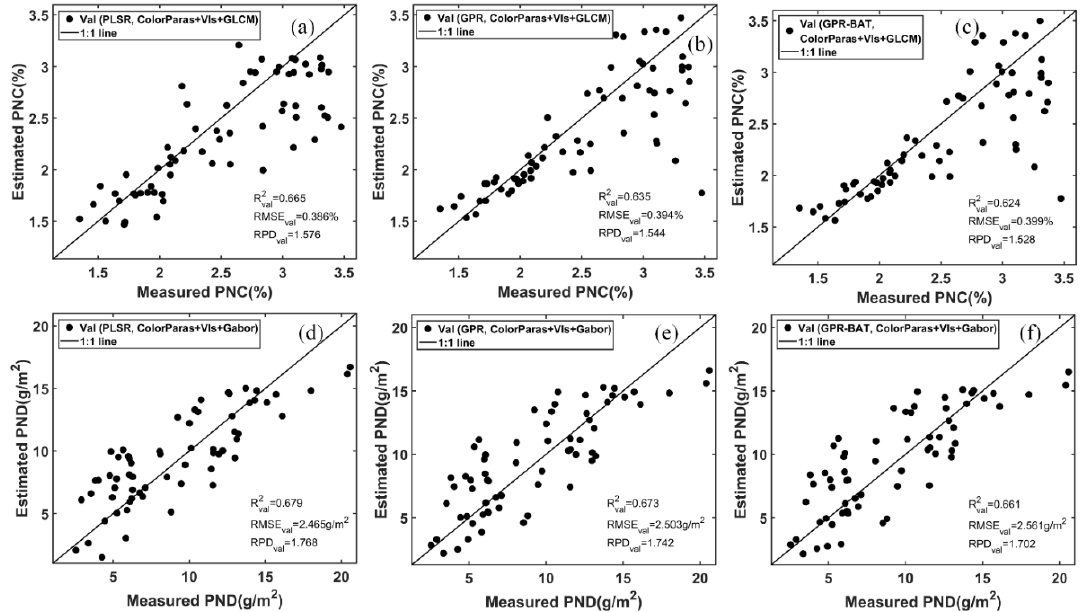
Figure 12. The predictive performance of the PLSR and GPR models based on the combination of textures, RGB-based Vis, and color parameters for ( a – c ) the PNC and ( d – f ) PND estimation of winter wheat.